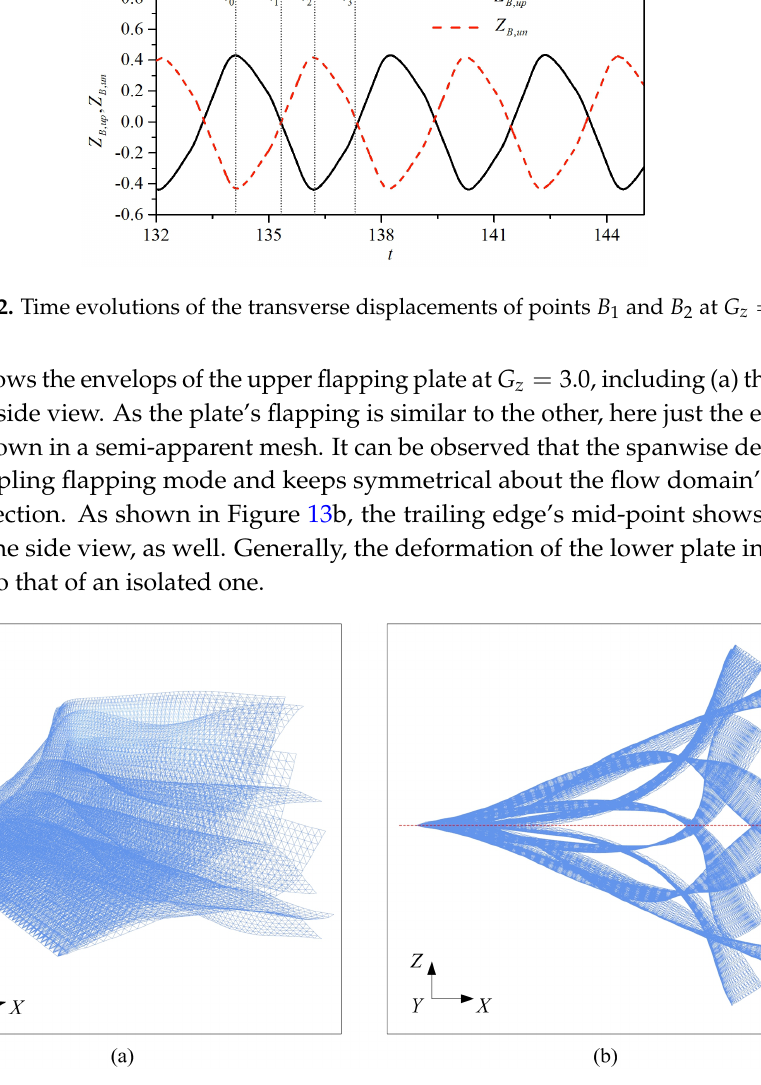
Figure 13. Envelops of the upper flapping plate at G z = 3.0: ( a ) axonometric view; ( b ) side